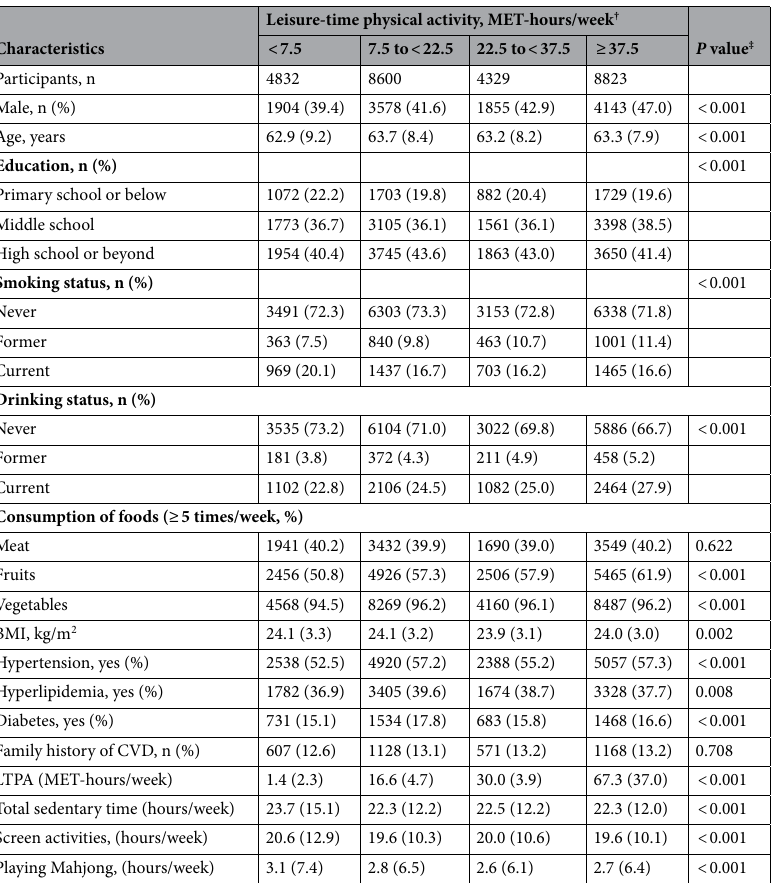
Table 1. Baseline characteristics of study participants according to leisure-time physical activity. BMI, body mass index; MET, metabolic equivalent of task. Data are means (SD) for continuous variables or number (percentages) for categorical variables. Missing data were 149, 58, 61, 2814, 264, 301, 224, 230, 26 and 241 for education, smoking status, drinking status, BMI, meat, fruits, vegetables, Mahjong, TV and total sedentary time. † < 7.5, 7.5–22.5, 22.5–37.5, and ≥ 37.5 MET-hours/week represented < 1, 1–3, 3–5, and ≥ 5 times of the minimum recommended LTPA level, respectively. ‡ P values were derived from one-way analysis of variance (ANOVA) for continuous variables, and Chi-square test for the categorical